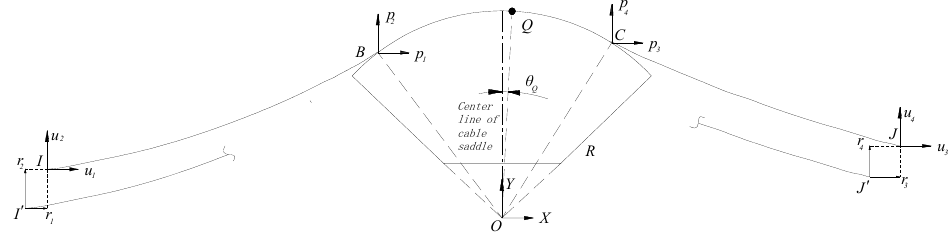
Figure 7. Schematic diagram of cable saddle force and deviation.